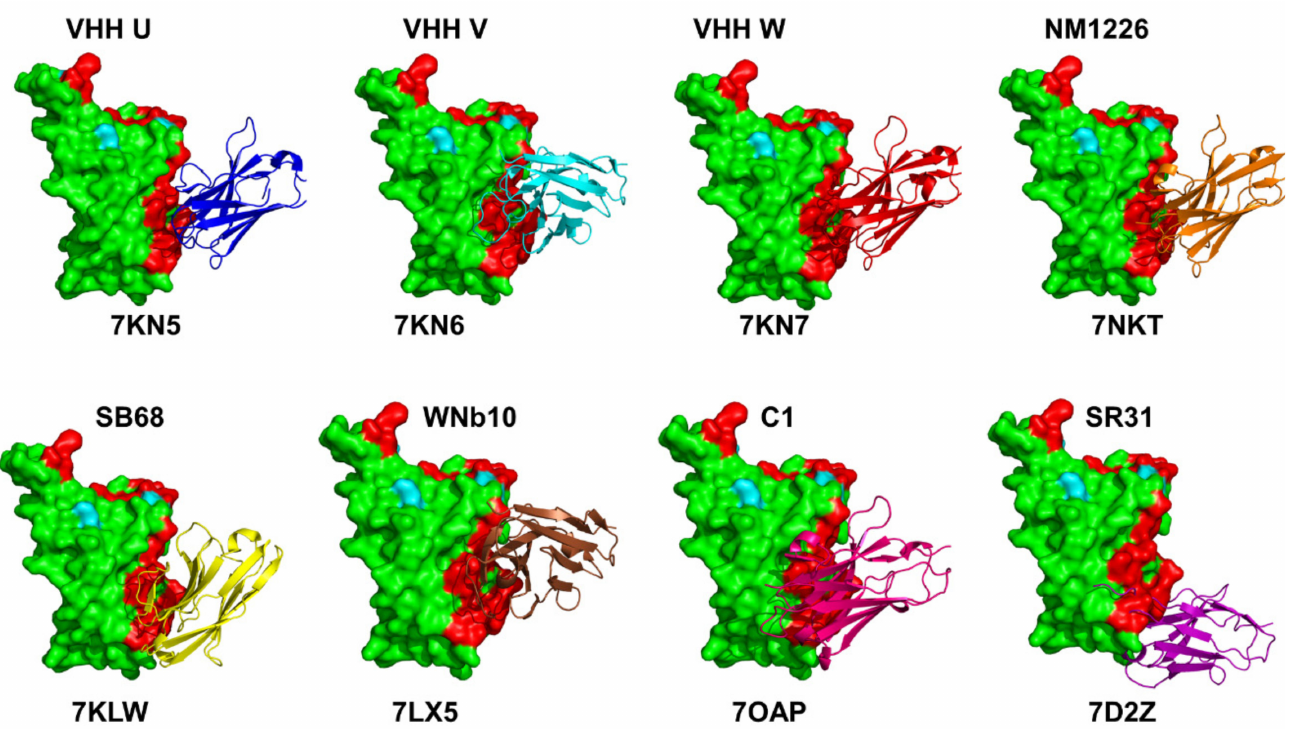
Figure 4. Structural details and binding modes for the class II nanobodies in complexes with S-RBD. The structures are shown for VHH-U (pdb id 7KN5), VHH-V (pdb id 7KN6), VHH-W (pdb id 7KN7), NM1226 (pdb id 7NKT) (top panel) and Sb68 (pdb id 7KLW), WNb10 (pdb id 7LX5), C1 (pdb id 7OAP), and SR31 (pdb id 7D2Z) (bottom panel). The S-RBD is shown in green surface. The nanobodies are shown in ribbons. Both ACE2- binding epitope and class II binding epitopes are shown in red-colored surface. A similarity of binding modes is seen for VHH U, VHH W, and NM1226. The unique binding modes in the cryptic binding site are seen for Sb68, WNb10, and especially SR31